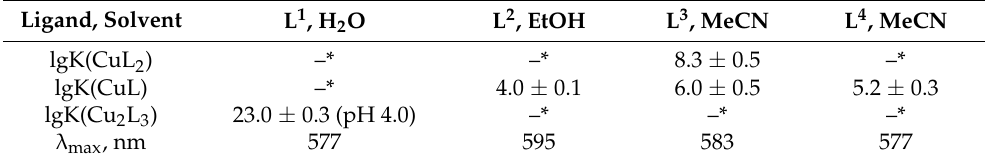
Figure 3. SERS spectra of the bispidine-based bis-azole ligands L 1 ( a ), L 2 ( b ), and L 3 ( d ) with Cu(II) ions at different concentrations. Spectra were measured on the silver nanostructured surface coated with the chitosan layer at 633 nm laser wavelength. ( c ) Typical UV-vis spectra of the triazole ligand L 3 with Cu(II) ions at the increasing L 3 concentration. Table 1. Stability constants of complexes of bispidine-based bis-azoles with Cu(II) with various stoichiometry. Stability constants were calculated based on the UV-vis measurements using the Bouguer-Lambert-Beer law and the mass action law (see Supplementary Information